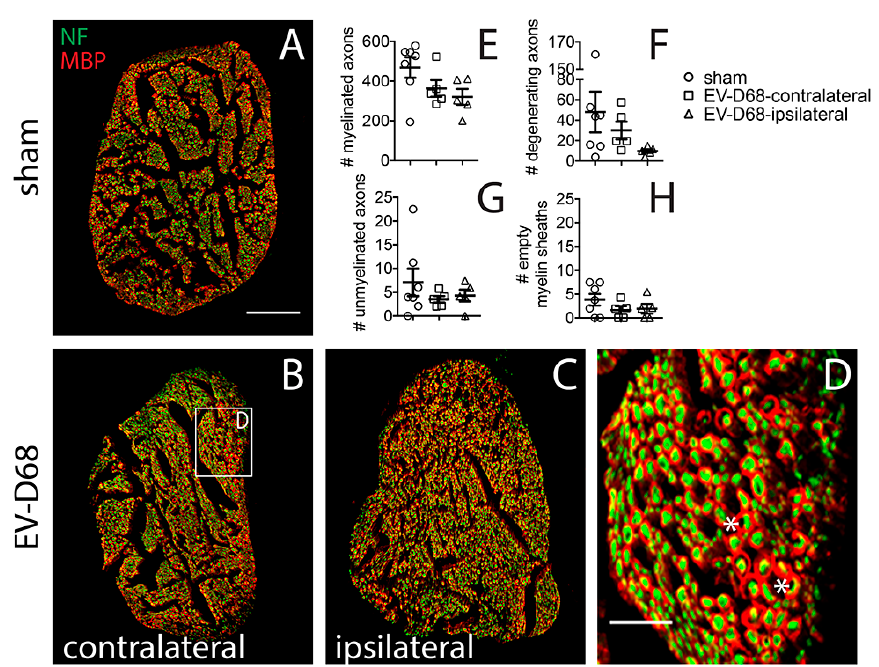
11 of 21 Figure 6. Reduced motor neurons in lumbosacral spinal cords of AG129 mice. ( A ) ChAT ir, GFAP ir, and EV-D68 ir in lumbosacral spinal cords of #252 sham- and #489 EV-D68-infected mice on ipsilateral and contralateral sides (infected i.p. 10 dpi, 6 weeks after paralysis onset); ( B ) Quantification of ChAT